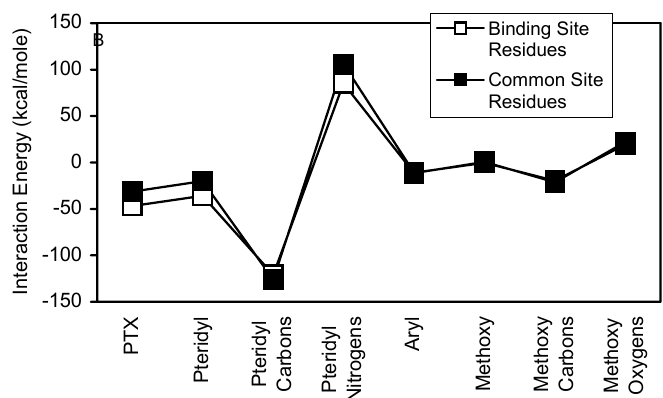
Figure 15 . Comparison of binding site and common site interaction with PTX and its substructural regions.